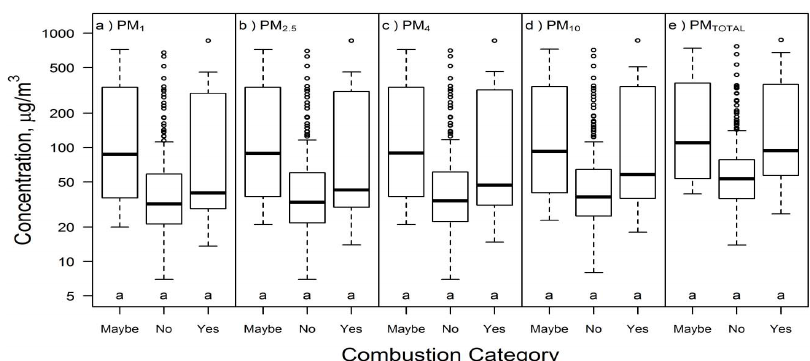
Figure 3. Airborne PM mass concentration ( µ g/m 3 ) in Building E (both campaigns) for ( a ) PM 1 ; ( b ) PM 2.5 , ( c ) PM 4 ; ( d ) PM 10 ; and ( e ) PM TOTAL based on investigator-observed combustion activities during measurements: yes = combustion source during sampling ( n = 12), maybe = investigators observed incense or cigarettes ( n = 8), and no = no investigator observations of combustion or likely combustion sources ( n = 203). Different letters within the same box represent statistically significant ( p < 0.05) groups under the Kruskal ‐ Wallis multiple comparisons test.